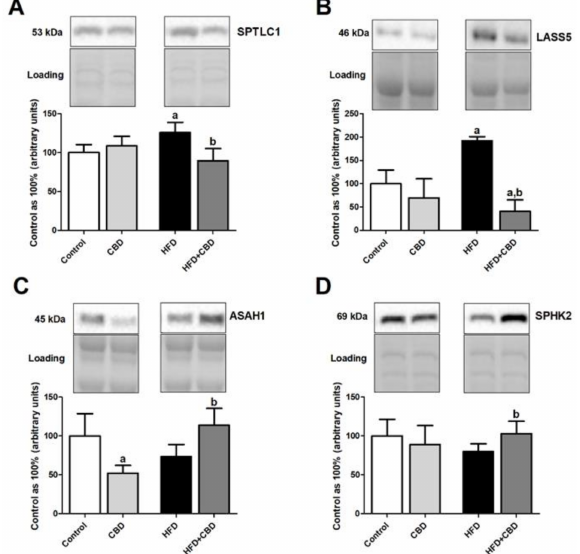
Figure 2. The total expression of proteins involved in the sphingolipid metabolism, e.g., ( A ) serine palmitoyltransferase, long chain base subunit 1 (SPTLC1), ( B ) ceramide synthase 5 (LASS5), ( C ) acid ceramidase (ASAH1), and ( D ) sphingosine kinase 2 (SPHK2), in the red gastrocnemius muscle in the control (standard diet) and high-fat diet (HFD) groups after chronic cannabidiol (CBD) treatment. The total expressions of the above proteins are presented as a percentage di ff erence compared to the control group, which was set as 100%. The data are expressed as mean values ± SD, n = 6 in each group. a p < 0.05 significant di ff erence: control group vs. examined group; b p < 0.05 significant di ff erence: HFD vs. HFD +